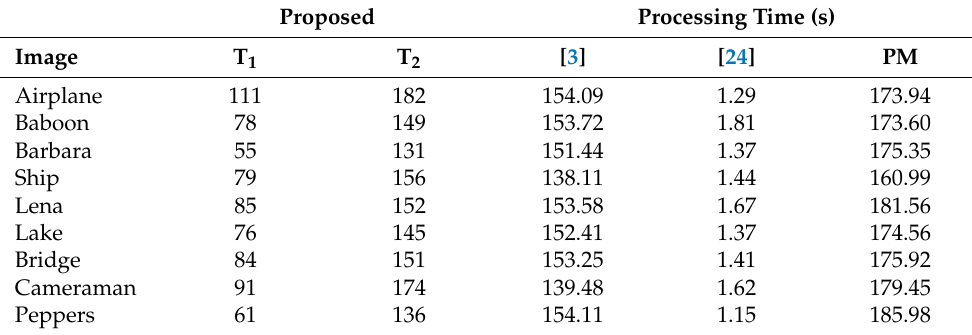
Table 3. A comparison of the processing times in common